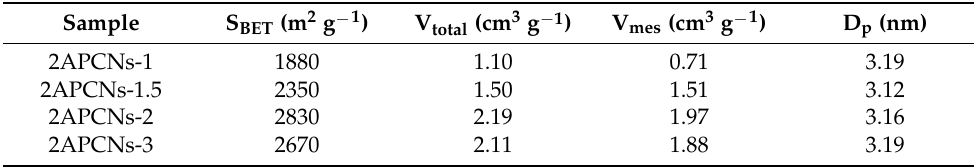
Figure 3. The adsorption isotherm curve and pore size distribution diagram of different activation holding time in two-step activation method: ( a ) adsorption isotherm curve of different holding time; ( b ) pore size distribution of 2APCNs-1; ( c ) pore size distribution of 2APCNs-1.5; ( d ) pore size distribution of 2APCNs-2; ( e ) pore size distribution of 2APCNs-3. Table 2. Pore characteristics of the materials prepared with different activation holding time in the two-step activation method. (S BET is specific surface area, V total is total pore volume, V mes is mesopore volume and D p is diameter